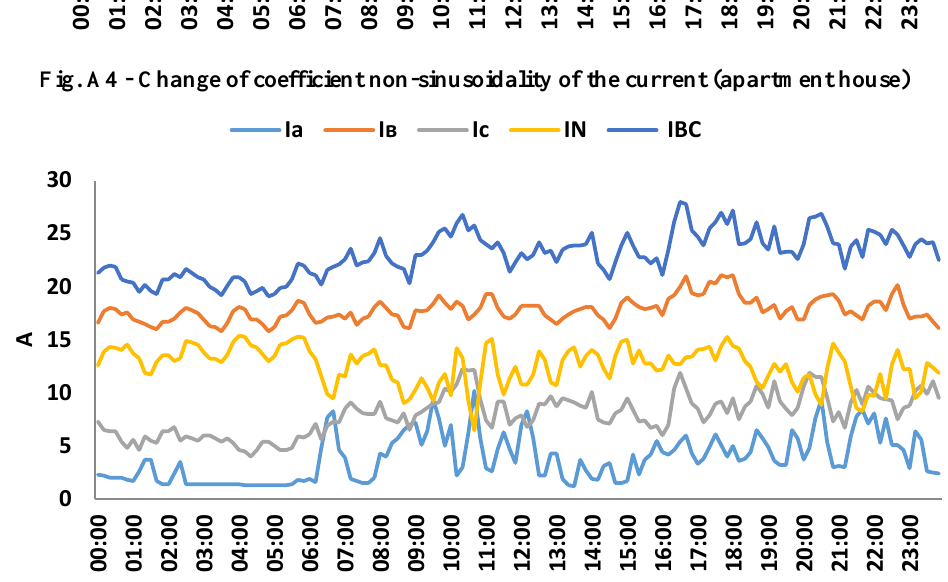
Fig. A5 - Change of the phase currents on input of the private house